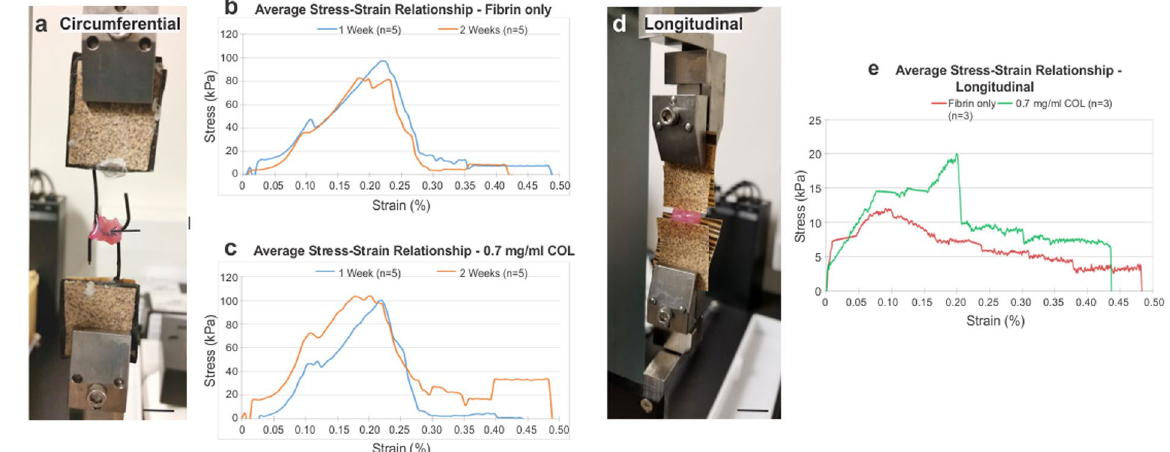
Figure 4. Adventitia vessels composed of 0.7 mg/ml collagen and cultured for 2 weeks exhibited highest ultimate tensile strength. Circumferential tensile testing ( a ), setup for the adventitia ring stacks (scale bar = 1 cm); ( b ), average stress-strain curves for Fibrin only vessels cultured for 1 week (n = 5) and 2 weeks (n = 5); and ( c ), average stress-strain curves for 0.7 mg/ml COL vessels cultured for 1 week (n = 5) and 2 weeks (n = 5). Ultimate tensile strength was highest for 0.7 mg/ml COL vessels cultured for 2 weeks, however, the difference in UTS between this group and the other three was non-significant. Longitudinal tensile testing ( d ), setup for the adventitia ring stacks with sandpaper grips on either end of the vessel length (scale bar = 1 cm); and ( e ), average stress-strain curves for 2 week cultured Fibrin only (n = 3) and 0.7 mg/ml COL vessels (n = 3). Average longitudinal UTS was similar for both groups, with a non-significant difference.